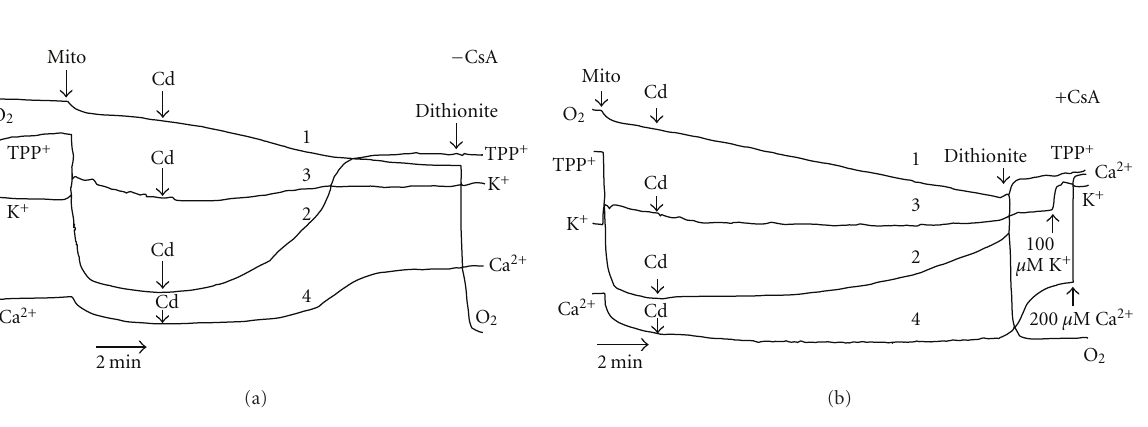
Figure 8: Simultaneous recordings of four mitochondrial parameters (respiration, ΔΨ mito, K + , and Ca 2+ fluxes) with the help of O 2 , TPP + , K + , and Ca 2+ -selective electrodes after treatment of isolated RLM with Cd 2+ in the absence (a) or presence of CsA (b). The additions of Cd 2+ (5 µ M) are indicated by arrows. The remainder is as in Figure